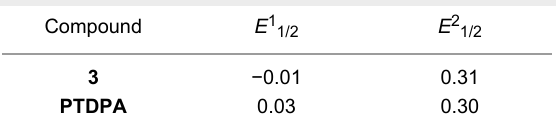
Figure 5: Electronic spectra of (a) 3 and its cationic species, and (b) PTDPA and its cationic states of PTDPA-(+1) and